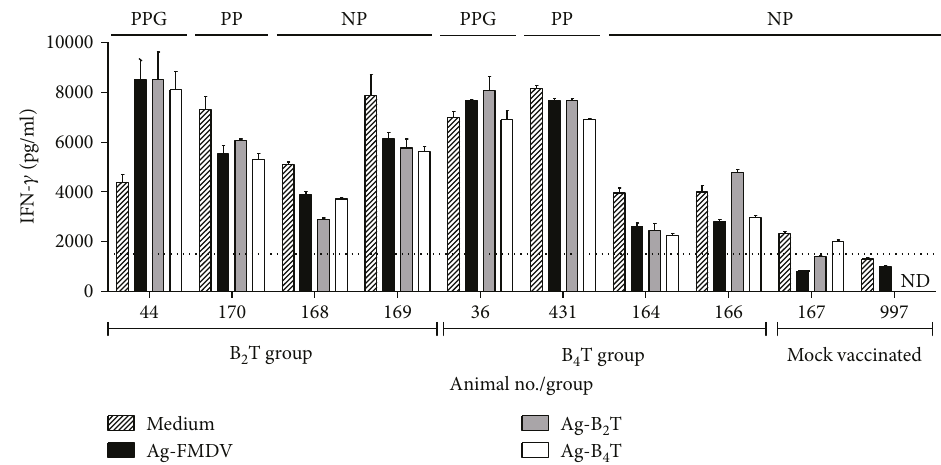
Figure 4: IFN- γ production by PBMC from peptide-vaccinated bovines after challenge. PBMC were puri fi ed at 3 dpc and cultured in the presence of peptide or inactivated virus. The supernatants were tested by a sandwich ELISA. Results are expressed in pg/ml by interpolation in a cytokine standard curve. Each bar represents the mean value of 2 replicates of supernatants ± SD. PPG: protected against podal generalization; PP: partial protected; NP: